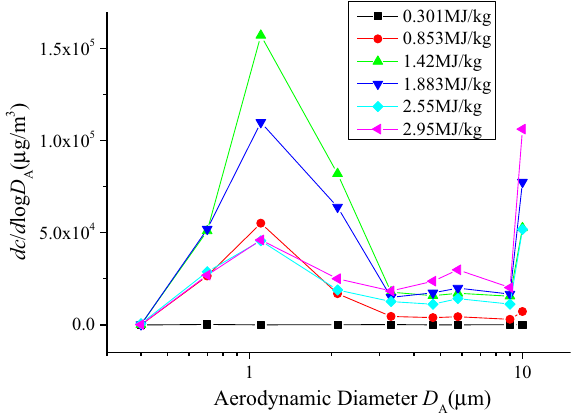
Figure 2. Mass concentration-size distribution of silver aerosol at different specific internal energy input. The concentrations were calculated by assuming the spatial distribution of aerosols was uniform, since strong turbulences were produced in the explosion room right after the explosion.